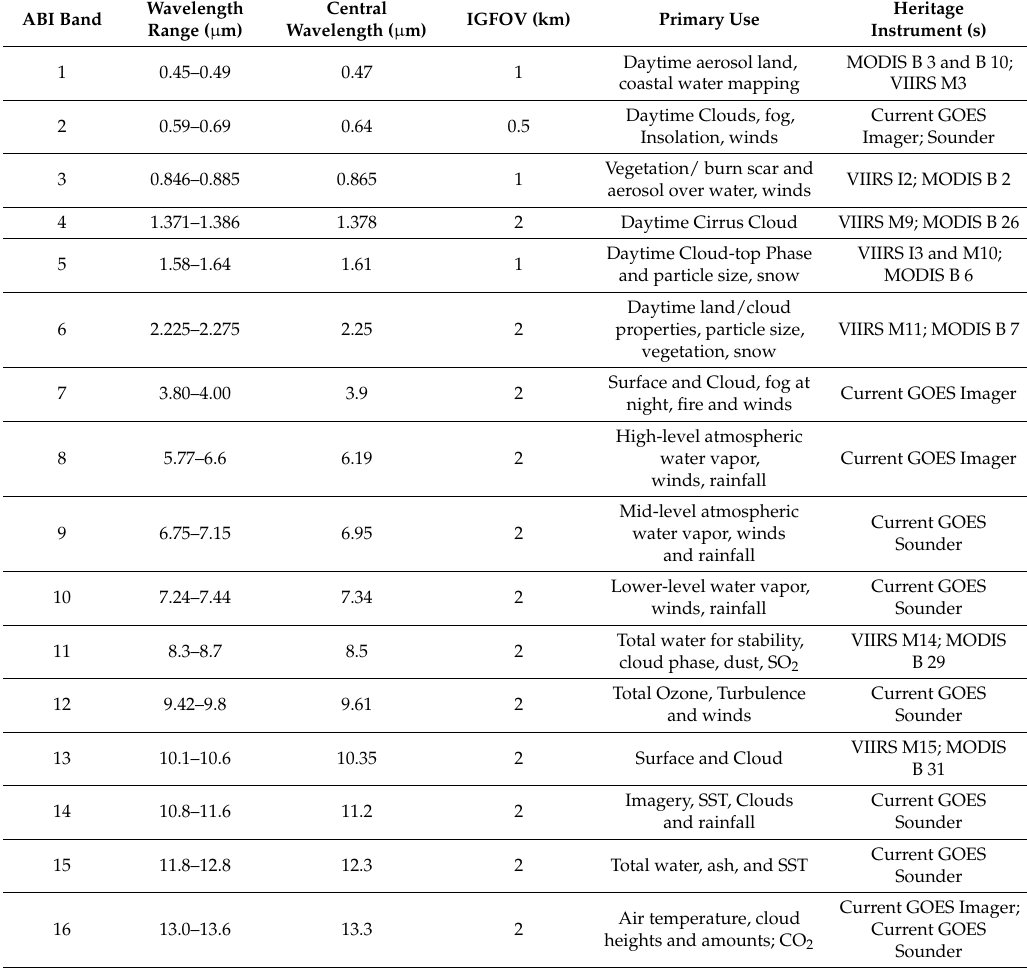
Advanced Baseline Imager (ABI) Spectoral band data and equivalent bands in heritage